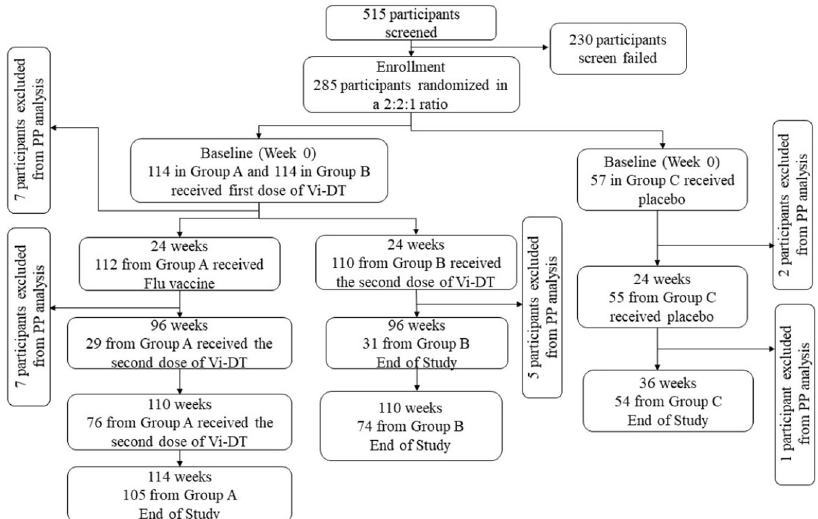
Fig. 1 Flow diagram of participant disposition (CONSORT fl ow diagram). PP — per-protocol analysis. Group A represents the late-booster group, Group B represents the early booster group, and Group C represents the comparator group. A total of 230 potential participants failed screening at enrollment for not ful fi lling the inclusion/exclusion criteria. The most common reasons for screen failure included abnormal screening laboratory values, including deranged liver enzymes, anemia, and abnormal hematology — 77 (33.5%); withdrew consent at enrollment — 48 (20.9%), had acute illnesses as a reason for presentation to the facility — 45 (19.6%); refused consent at screening — 25 (10.9%); parents/legal authorized guardians indicated that they have a plan to move out of the study area and will not be able to follow study